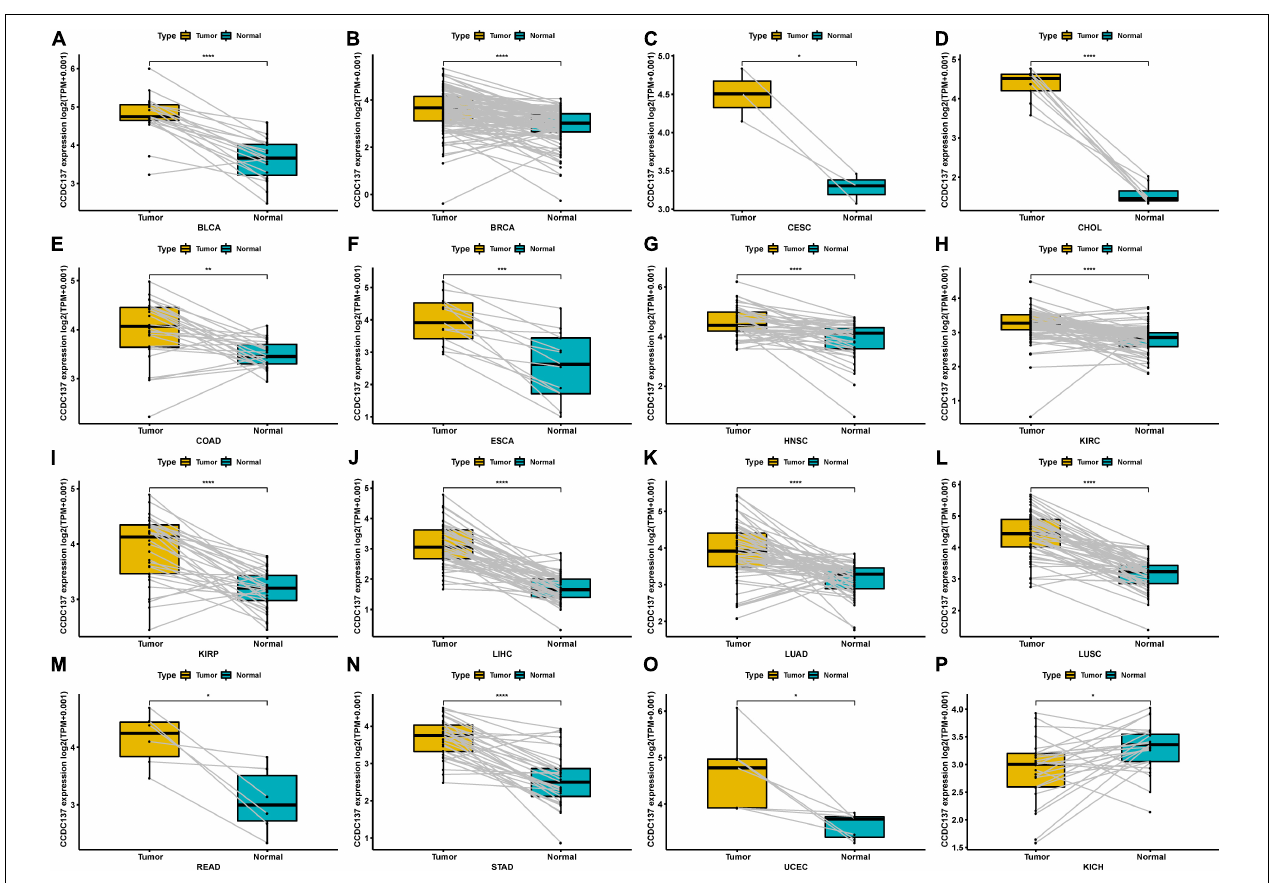
FIGURE 2 | Pan-cancer CCDC137 expression in paired tumor and normal tissues. (A–P) CCDC137 expression in paired tumor and adjacent normal tissues in indicated tumor types in TCGA cohort. Data shown as mean ± SD. * p < 0.05, ** p < 0.01, *** p < 0.001, and **** p <